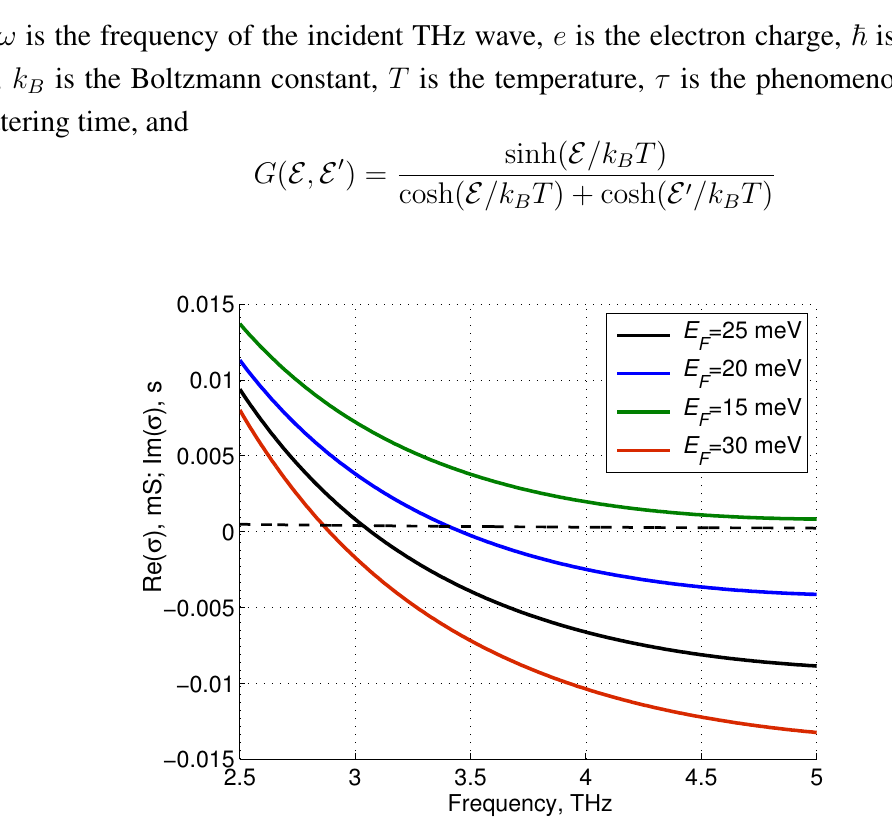
Imaginary part F